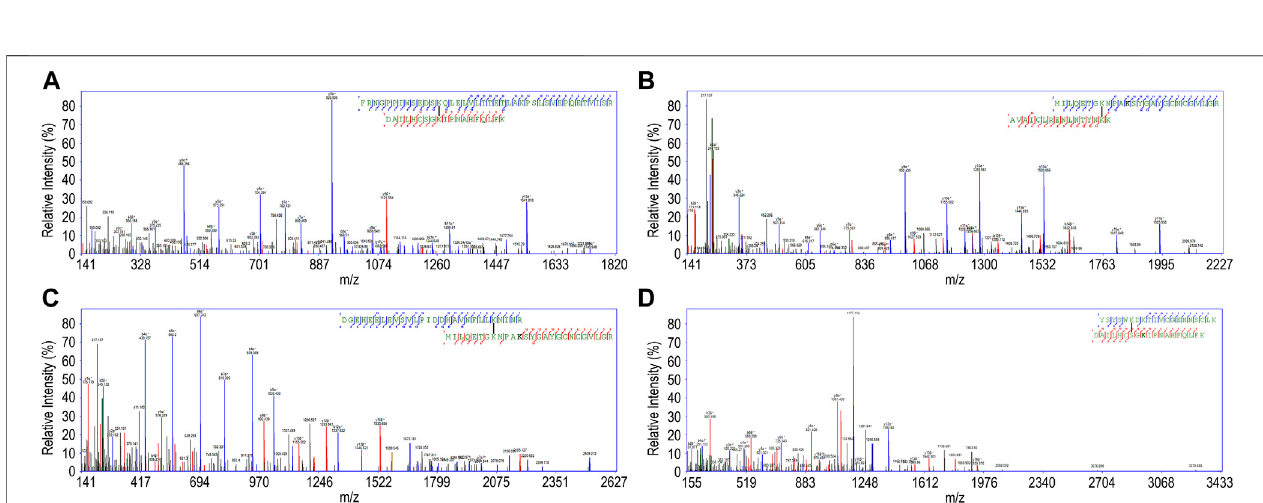
FIGURE 3 | Gel electrophoresis analysis of the cross-linking reaction between DM64 and myotoxin II (1:1 mol/mol). The toxin-antitoxin noncovalent complex was stabilized with BS 3 (90 min reaction time at 25 ° C, protein to cross-linker ratio of 1:2,800 mol/mol) and analyzed by (A) native PAGE and (B) SDS-PAGE under reducing conditions. All samples were run on 12% T gels stained with silver nitrate. MM: molecular mass markers; lane 1: DM64; lane 2: DM64 + BS 3 ; lane 3: DM64 + myotoxin II (mtx II); lane 4: (DM64 + mtx II) + BS 3 ; lane 5: mtx II; lane 6: mtx II + BS 3 .